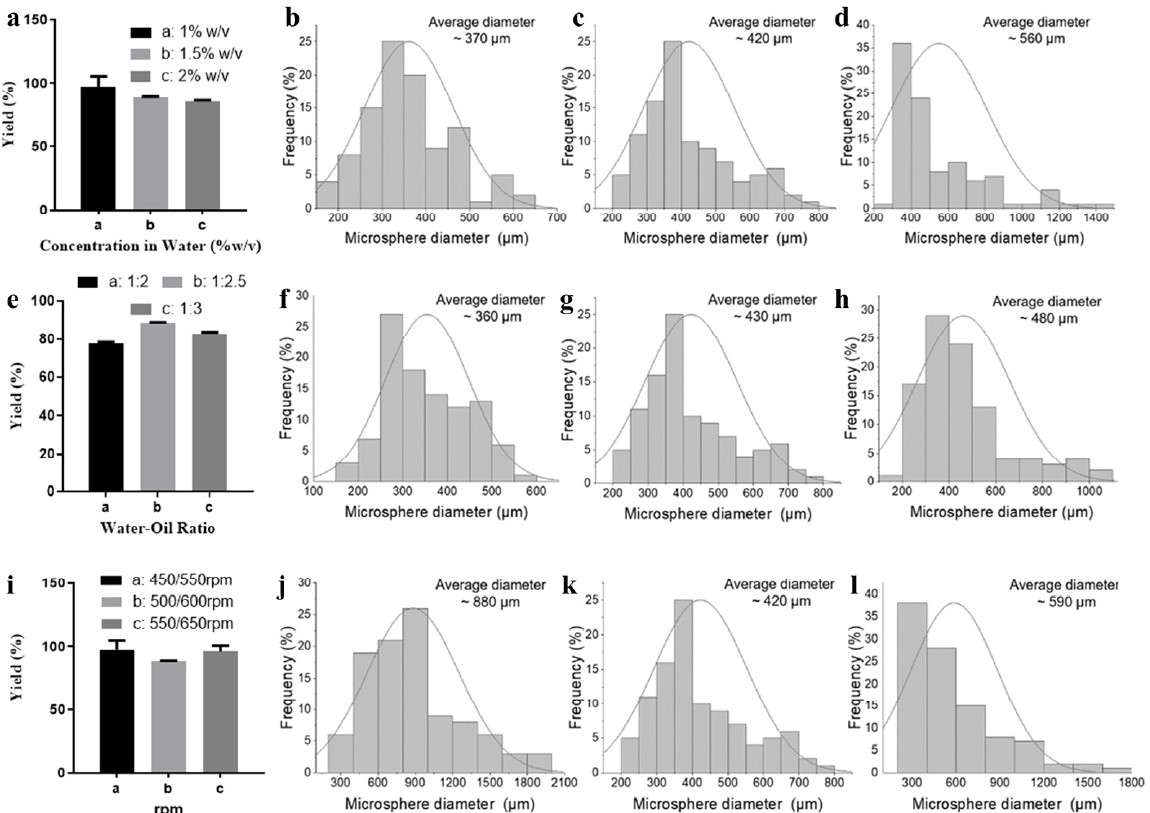
Figure 1. Microsphere yield, average diameter, and size distribution under different conditions: ( a ) Microsphere yield under a water–oil ratio of 1:2.5 and a stirring rate at 500–600 rpm (gelatin/sodium alginate concentration of 1, 1.5, and 2%); ( b – d ) average diameter and size distribution of a micro- sphere obtained under gelatin/sodium alginate concentration of 1, 1.5, and 2% ( w/v ); ( e ) microsphere yield under a gelatin/sodium alginate concentration of 1.5% ( w/v ) and a stirring rate at 500–600 rpm (water-oil ratio of 1:2, 1:2.5, and 1:3); ( f – h ) average diameter and size distribution of a microsphere obtained under a water–oil ratio of 1:2, 1:2.5, and 1:3; ( i ) microsphere yield under a gelatin/sodium alginate concentration of 1.5% ( w/v ) and a water–oil ratio of 1:2.5 (stirring rate at 450–550, 500–600, and 550–650 rpm); ( j – l ) average diameter and size distribution of a microsphere obtained under a water–oil ratio of a stirring rate at 450–550, 500–600, and 550–650 rpm. 2.2. Influence of Cell Concentration on Encapsulation Rate in Microsphere The encapsulation of cells into a microsphere is described in Section of 4.4. As shown in Figure 2a,b, the cell encapsulation rate was dependent on the cell density, especially for RAW264.7 cells. Upon the density of a HSF cell amounted to 0.50 × 10 7 /mL, the cell encap- sulation rate was determined to be ~13% using a total DNA concentration as reference. The number of encapsulated HSF cells was correspondingly determined to be 2.00 × 10 6 /g. When RAW264.7 cell was encapsulated at the density of 0.50 × 10 7 /mL, the encapsulation rate was calculated to be ~40%. The encapsulated cell number was 5.00 × 10 6 /g. Increasing the density to 1.00 and 1.50 × 10 7 /mL, the encapsulated rate was determined to be ~32% and ~28, respectively. The corresponding encapsulated cell number was determined to be 6.50 and 7.80 × 10 6 /g.